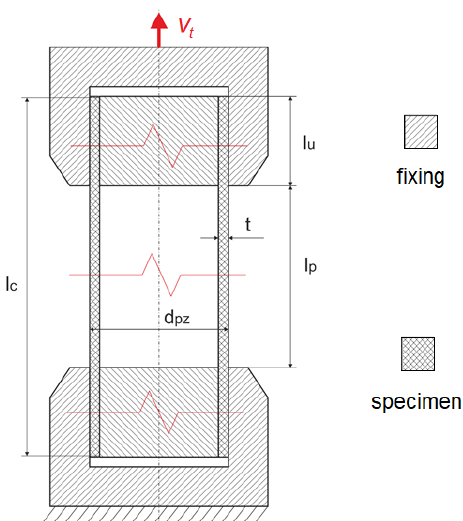
Figure 2. Schematic overview (cross section) of mounting of tubular specimens in the tensile test of the PLGA bioresorbable polymer (longitudinal tension). Table 2. Kinematic assumptions for a longitudinal tensile test of PLGA tubular-type specimens.